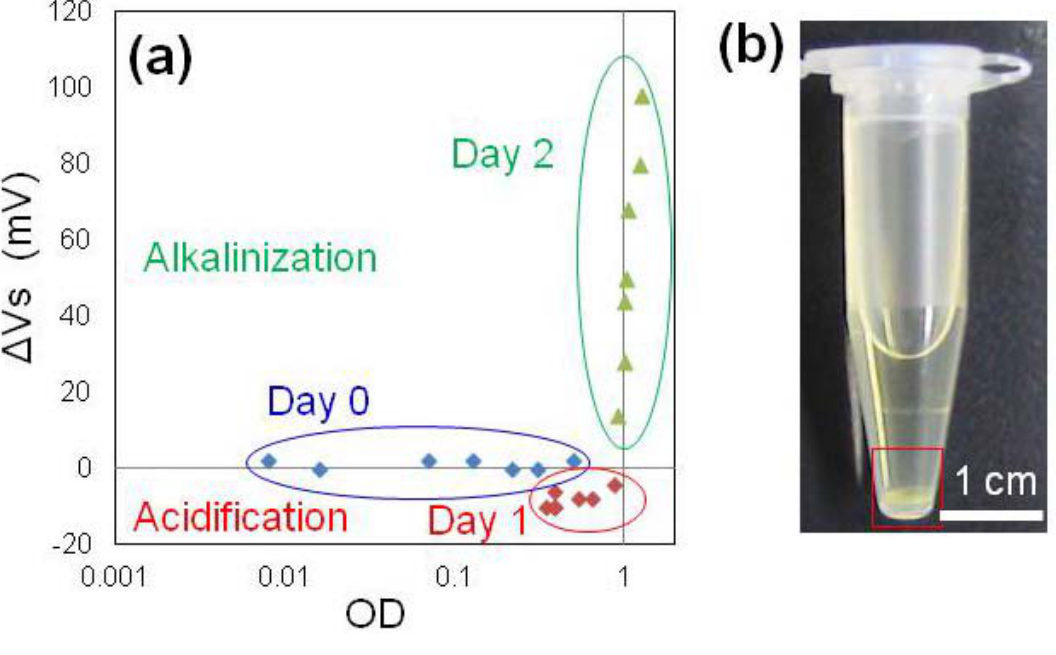
Figure 3. ( a ) Relationship between turbidity and pH measured by ISFET in medium containing M. luteus . Voltages in the vertical axis indicate the difference between the M. luteus suspension and the medium ( Δ V ). Absorbance is shown in a log scale. s ( b ) Biofilm formation in the PS microtube. A M. luteus biofilm was observed at the bottom of the microtube (red